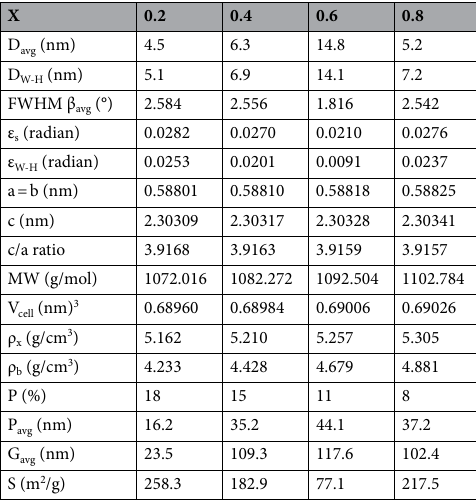
Table 1. Data on structural parameters of SLFO